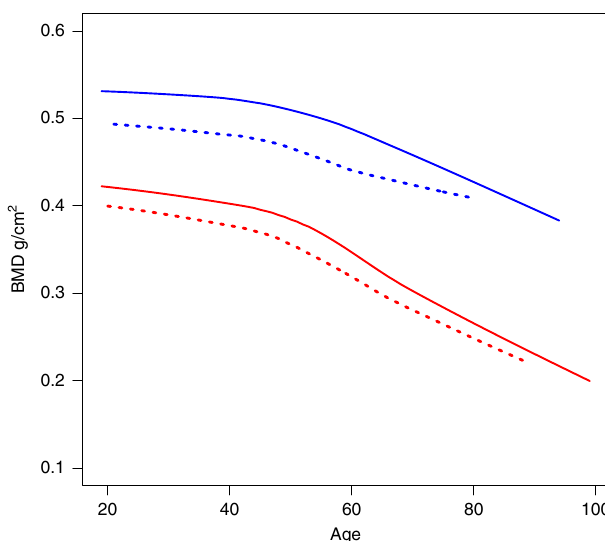
Fig. 2 Age trend in BMD for MEPE LoF mutation carriers. In this fi gure we have compared the forearm bone mineral density (BMD) in the MEPE loss- of-function (LoF) mutation, p.Lys70IlefsTer26, carriers (dotted lines) compared to non-carriers (solid lines) in the HUNT dataset ( N = 19,705). The trend over different ages is illustrated using LOWESS curve for males (blue lines) and females (red lines)